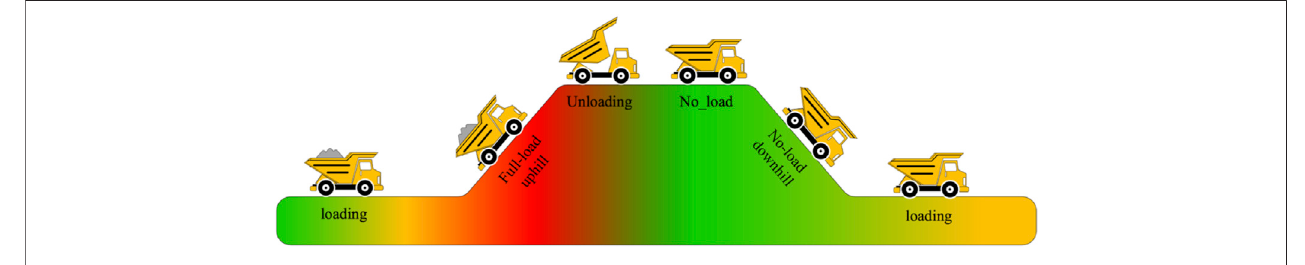
FIGURE 4 | Transportation route of the mining truck (W. Yang, 2020).